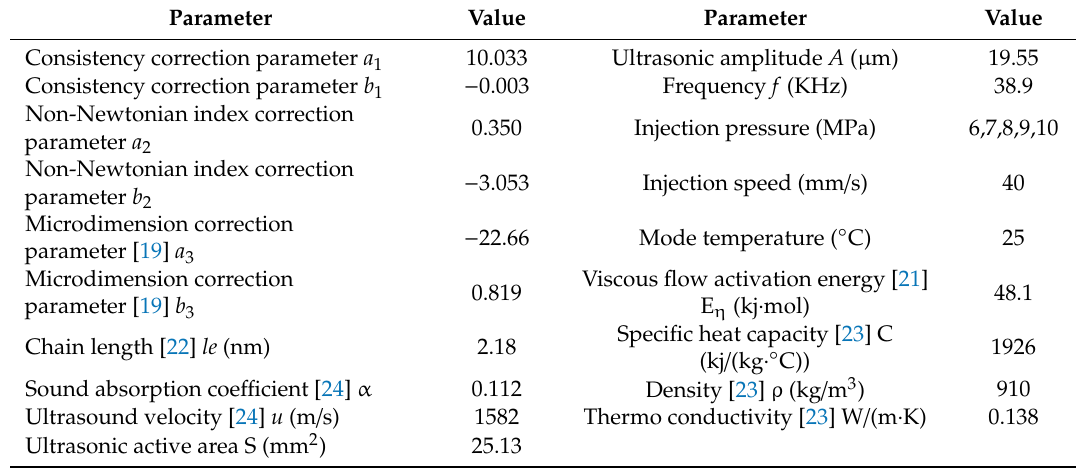
Table 3. MU viscosity model parameters and process parameters for